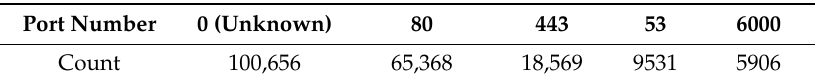
Table 9. Top 5 source ports with anomalous events.